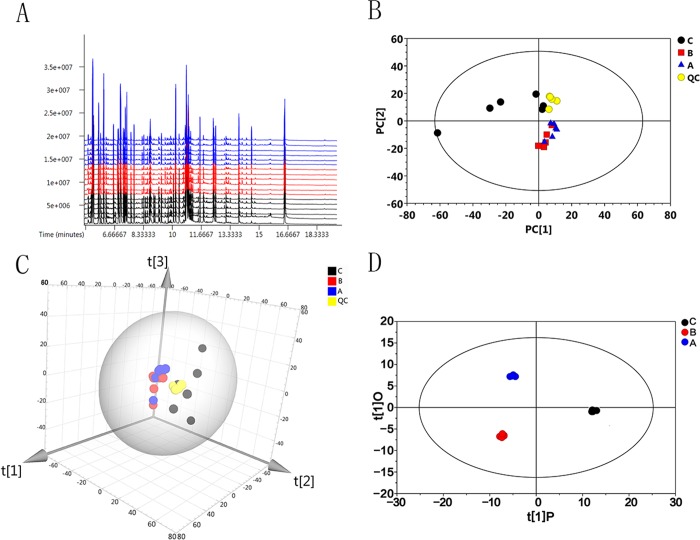
Serum metabolic profile of black rockfish exposed to different water temperatures obtained through GC-MS-TOF-based metabolomics and multivariate data analysis.A, total ion current chromatograms (TIC) of all samples. B, the two-dimensional scatter plot of the PCA model of three thermal groups and QC samples. C, the three-dimensional scatter plot of the PCA model of three thermal groups and QC samples. D, the scatter plot of the OPLS-DA model. The A, B and C labels in figure represent control group (16°C), low temperature group (5°C) and high temperature group (27°C), respectively.